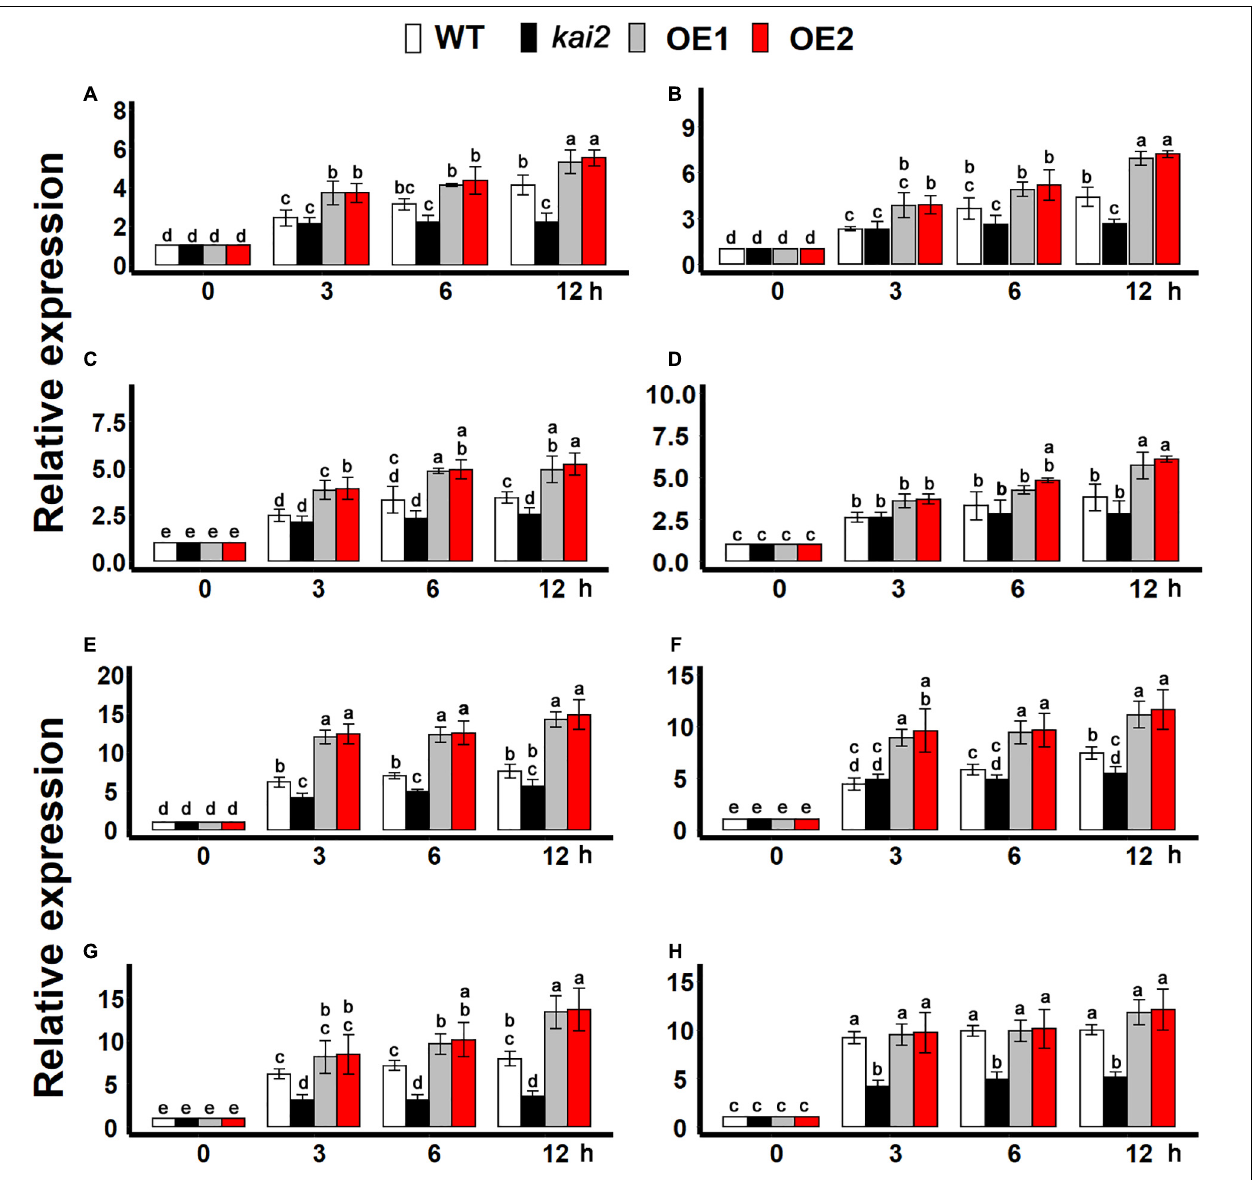
FIGURE 6 | SsKAI2 OEs have enhanced cold-acclimation-related genes. (A) CSP1 . (B) CSP2 . (C) CSP3 . (D) CSP4 . (E) CBF1. (F) CBF2. (G) CBF3. (H) CBF4. Expression of cold-acclimation-related genes was investigated in three plants of each line after 0- (control at 22 ◦ C), 3 − , 6 − , and 12 h of cold treatment (4 ◦ C). The samples were randomly taken from the leaves of five plants of each treatment. Arabidopsis thaliana ACTIN 2 was taken as a reference gene, and control treatment at 0 h was considered as 1. One-way ANOVA was used to analyzed all data, and HSD Tukey’s test was used to perform multiple comparisons at P < 0.05 significant level ( n = 3). Bars with uncommon letters showing significant difference at P < 0.05. An “h” at the X -axis of each graph represents time in hours under cold stress.